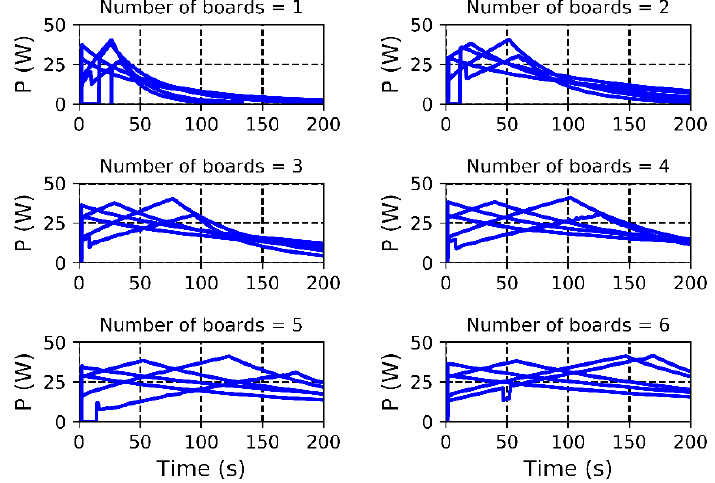
Figure 21. Voltage while charging according to the number of boards connected.